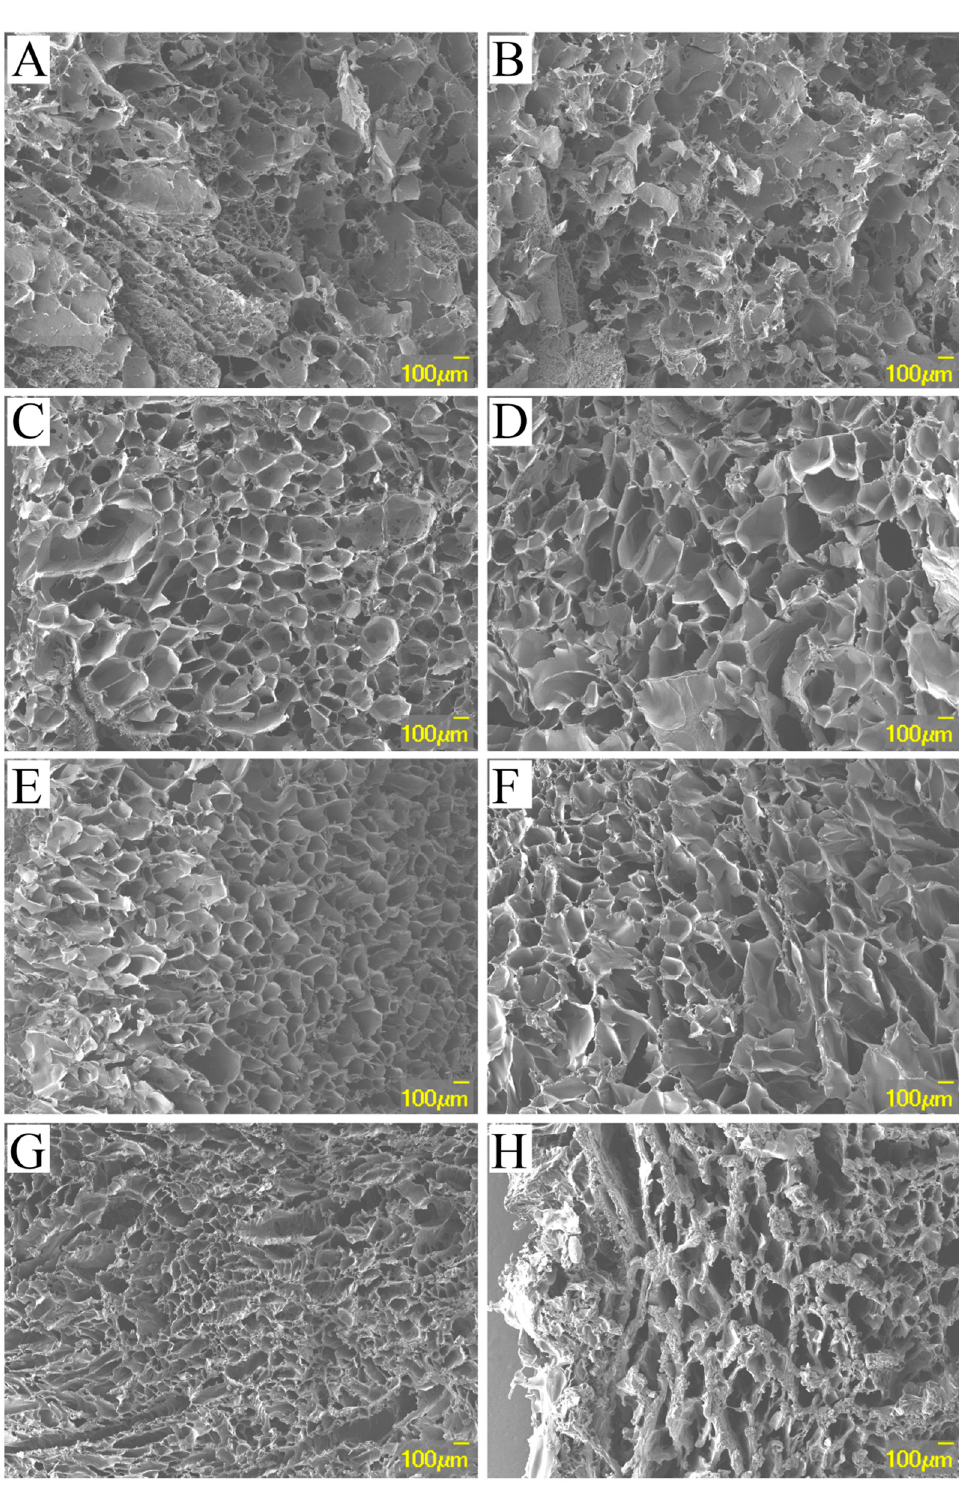
Figure 4. The SEM images of PPEA 0.05 ( A , B ), PPEA 0.1 ( C , D ), PPEA 0.2 ( E , F ), and PPEA 0.3 ( G , H ) before ( A , C , E , G ) and after ( B , D , F , H ) the Pb 2+ adsorption.